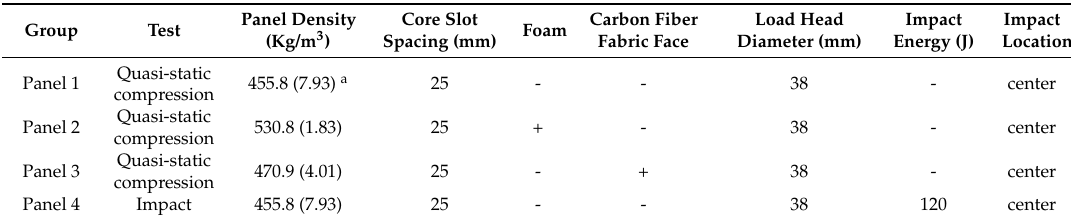
Table 2. Test method, density, core fabrication spacing and characteristics, test ball size, impact energy, and test